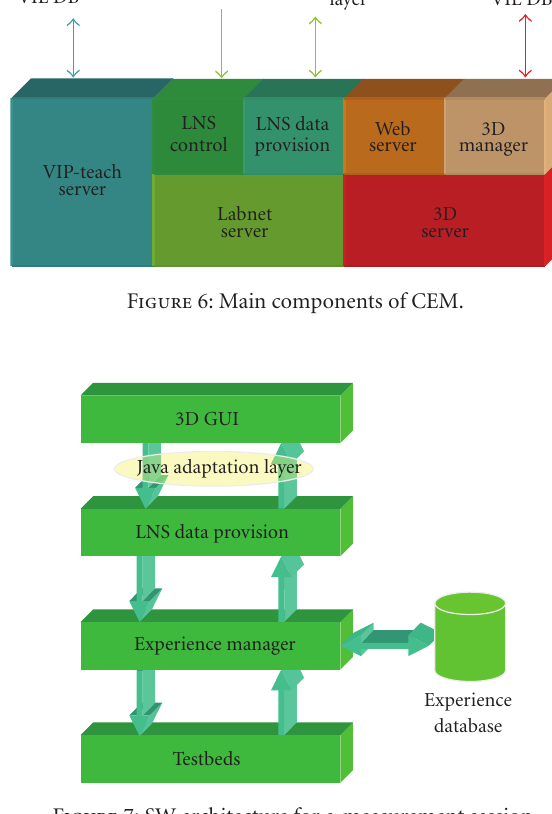
Figure 7: SW architecture for e-measurement